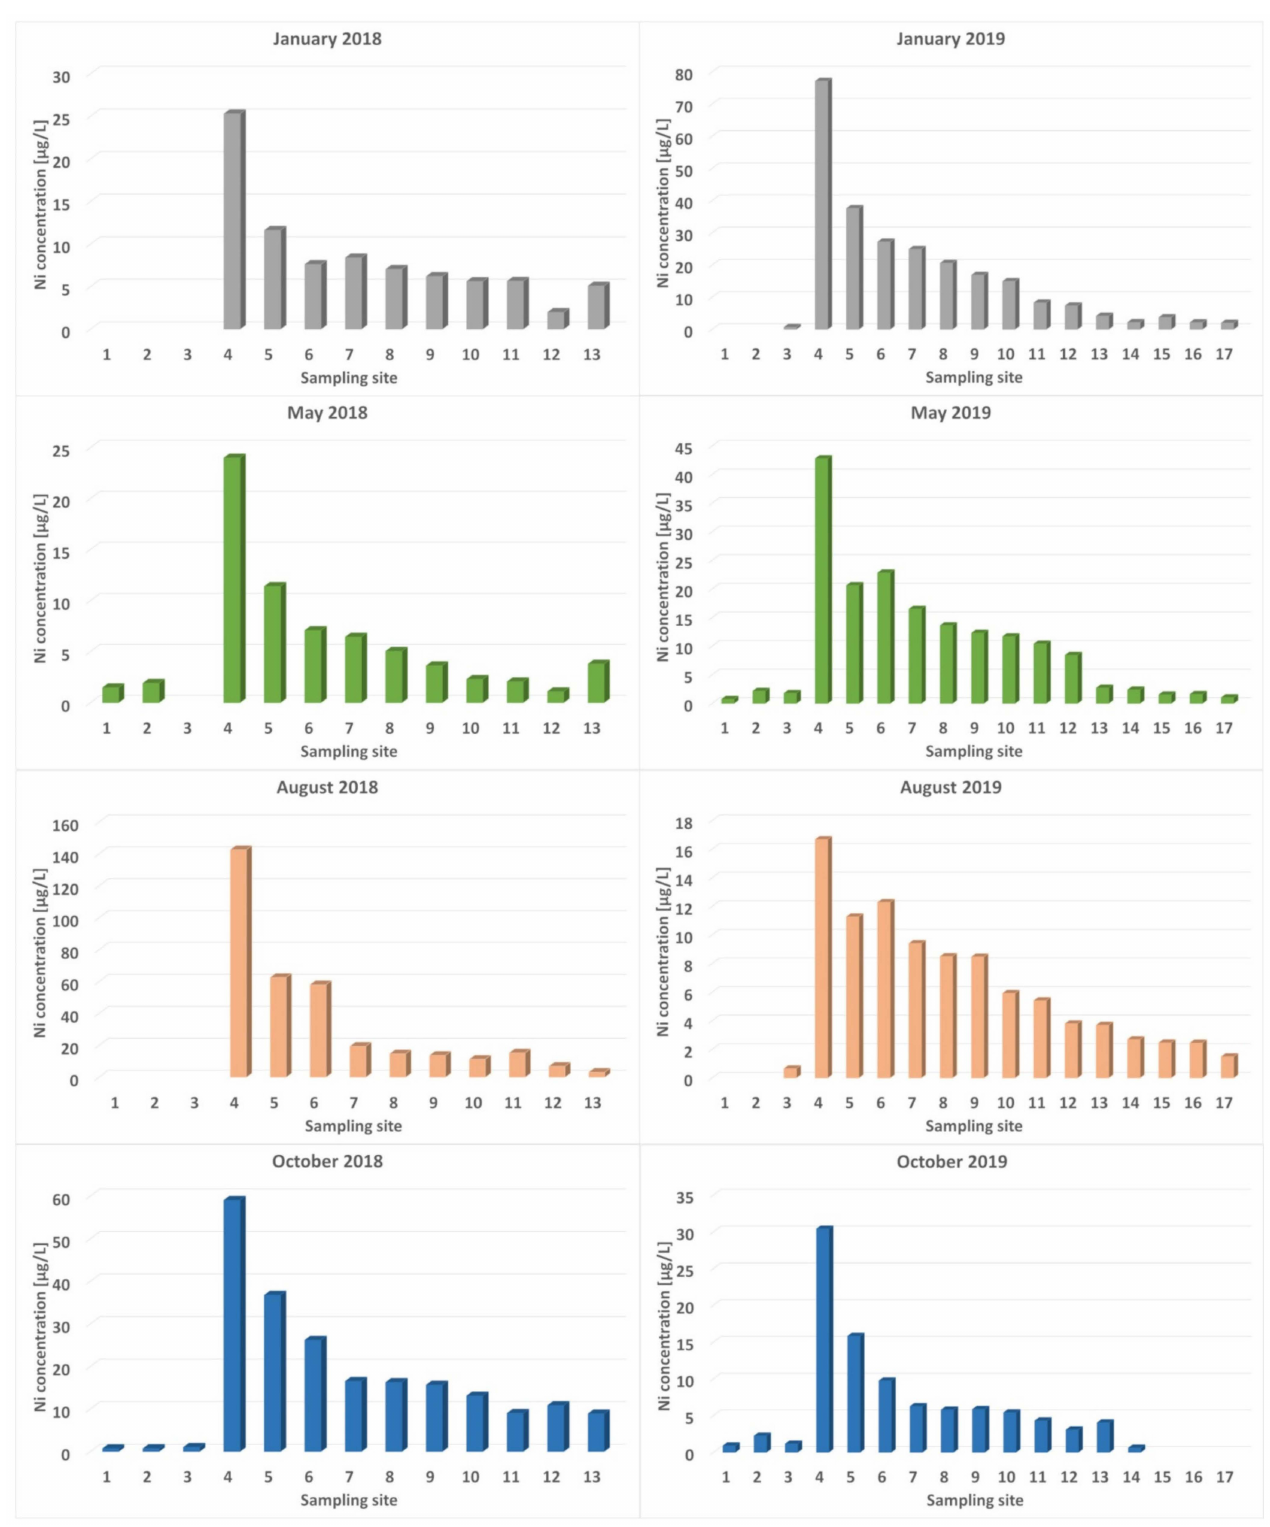
Figure 3. Variability of Ni concentrations in selected